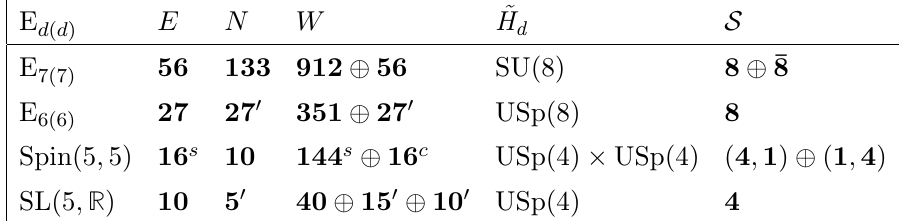
Table 1 . Generalised geometry groups, bundles and